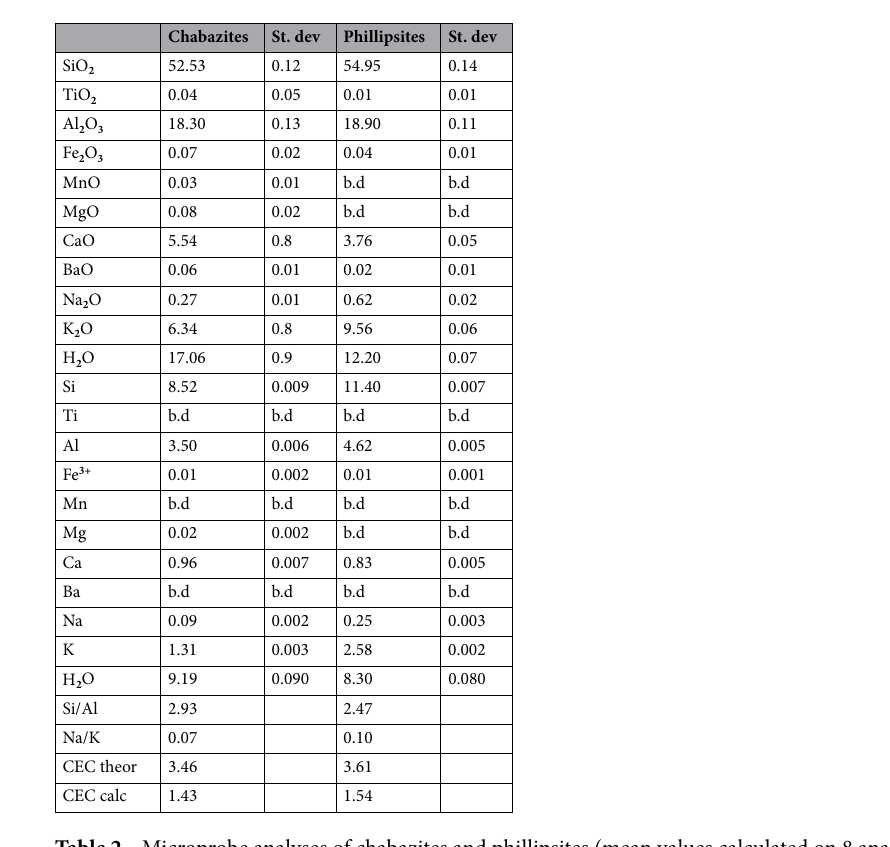
Table 2. Microprobe analyses of chabazites and phillipsites (mean values calculated on 8 analyses). Chemical formula is calculated on the base of 32 O for phillipsites and of 24 O for chabazites. CEC theor theorical cation exchange capacity, CEC calc calculated cation exchange capacity, b.d. below detection